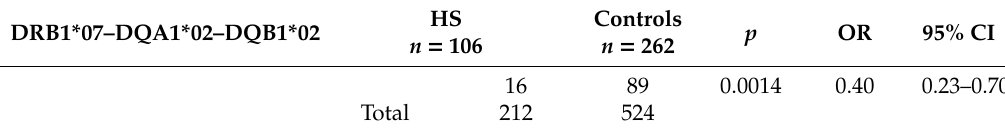
Table 4. Frequency of the HLA DRB1*07–DQBA1*02–DQB1*02 haplotype in HS patients and